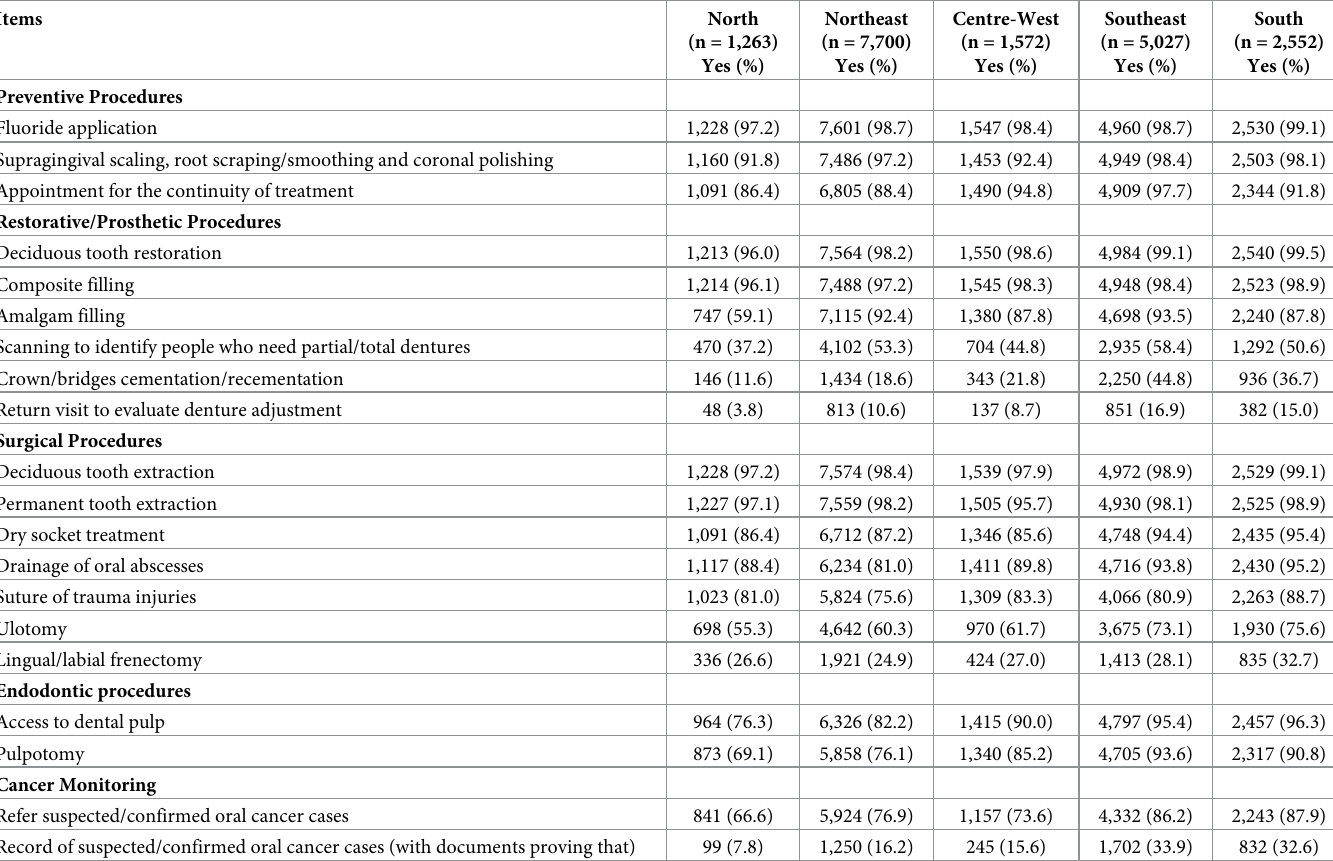
Table 2. Performance of each item provided in primary dental care according to the Brazilian Geographical Regions—North, Northeast, Centre-West, Southeast and South. Brazil, 2013–2014. Items